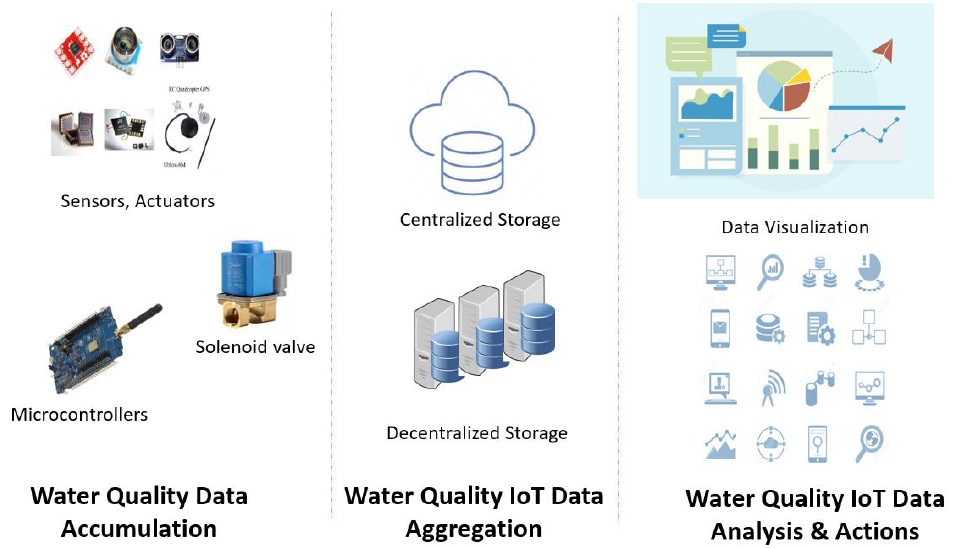
Figure 1. Proposed water quality analysis framework.